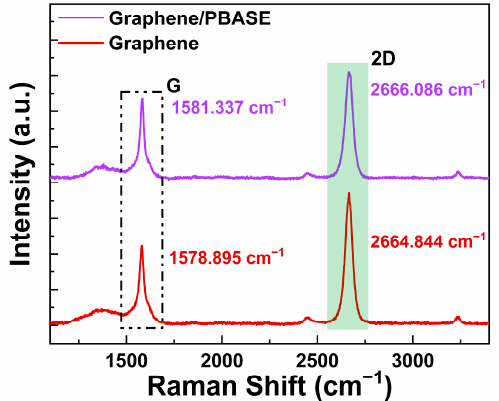
Figure 2. The Raman spectra of graphene film before and after the non-covalent functionalization of graphene surface using PBASE molecules.